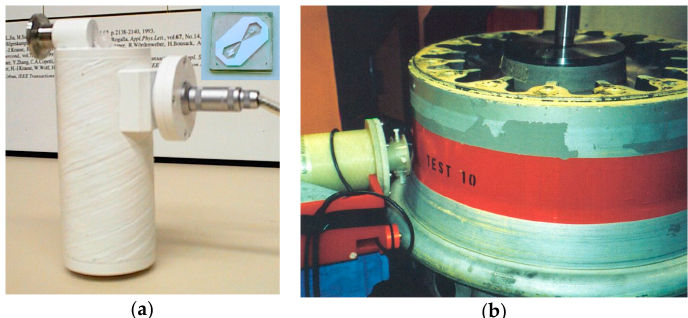
Figure 4. ( a ) Liquid nitrogen minicryostat used for the operation of a high-T c DC SQUID